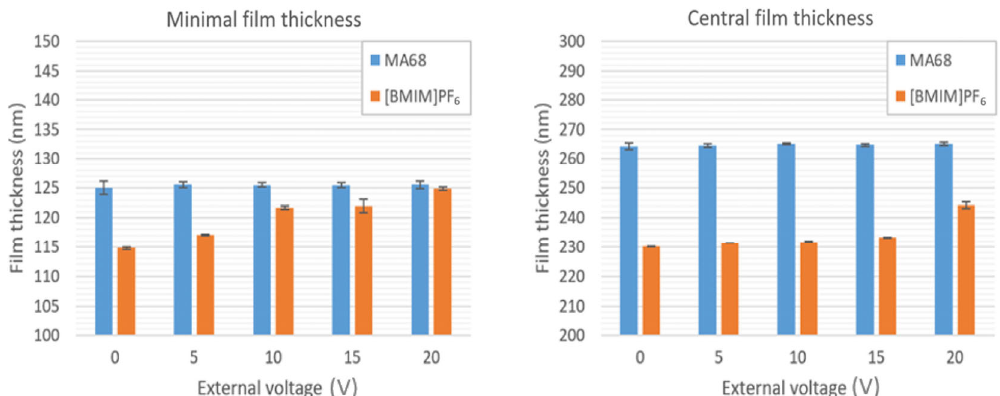
Fig. 4 Results of film thickness measurements with applied voltage.